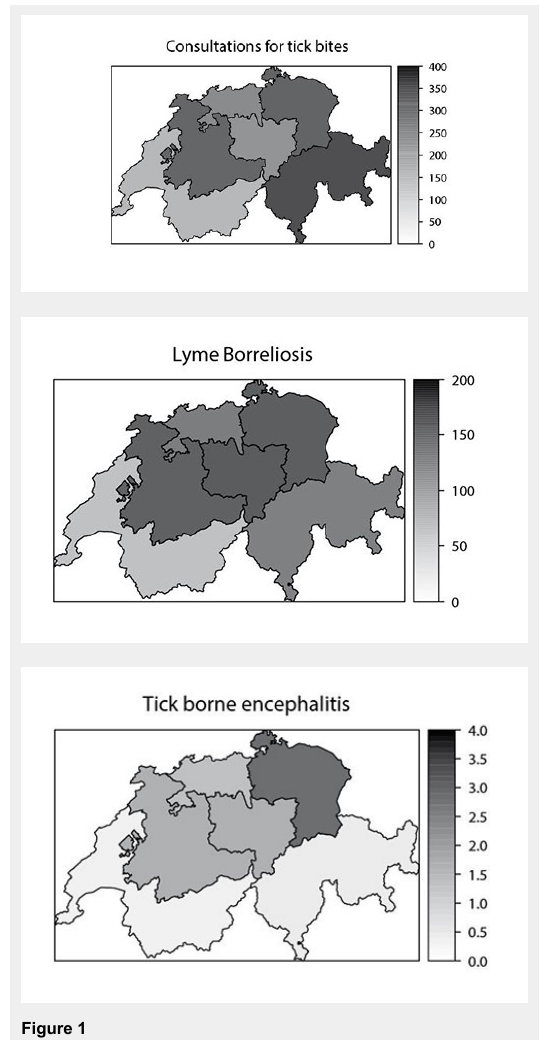
Geographic distribution by Sentinella Regions regarding treated tick bites, Lyme borreliosis and tick borne encephalitis, Switzerland 2008 to 2011. Panel 1: Treated tick bites, yearly incidence per 100,000 inhabitants, 2008–2011. Panel 2: Lyme borreliosis, yearly incidence per 100,000 inhabitants, 2008–2011. Panel 3: Tick borne encephalitis, yearly incidence per 100,000 inhabitants, 2008–2011